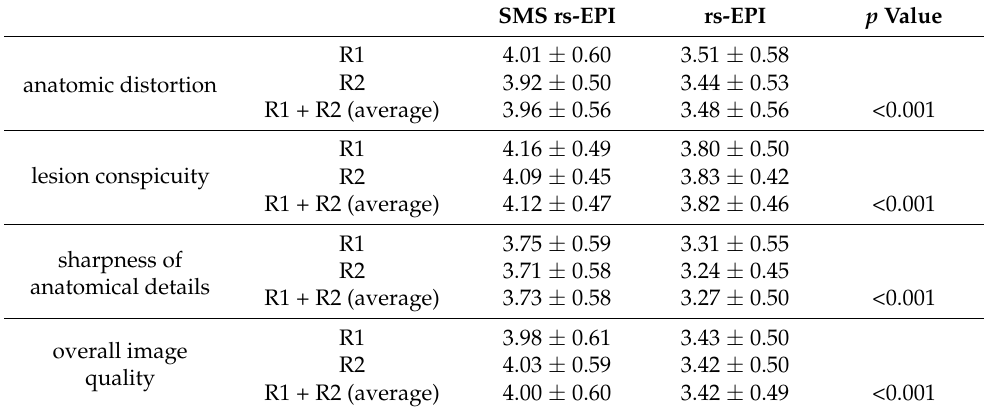
Table 2. Subjective image quality assessment of SMS rs-EPI and conventional